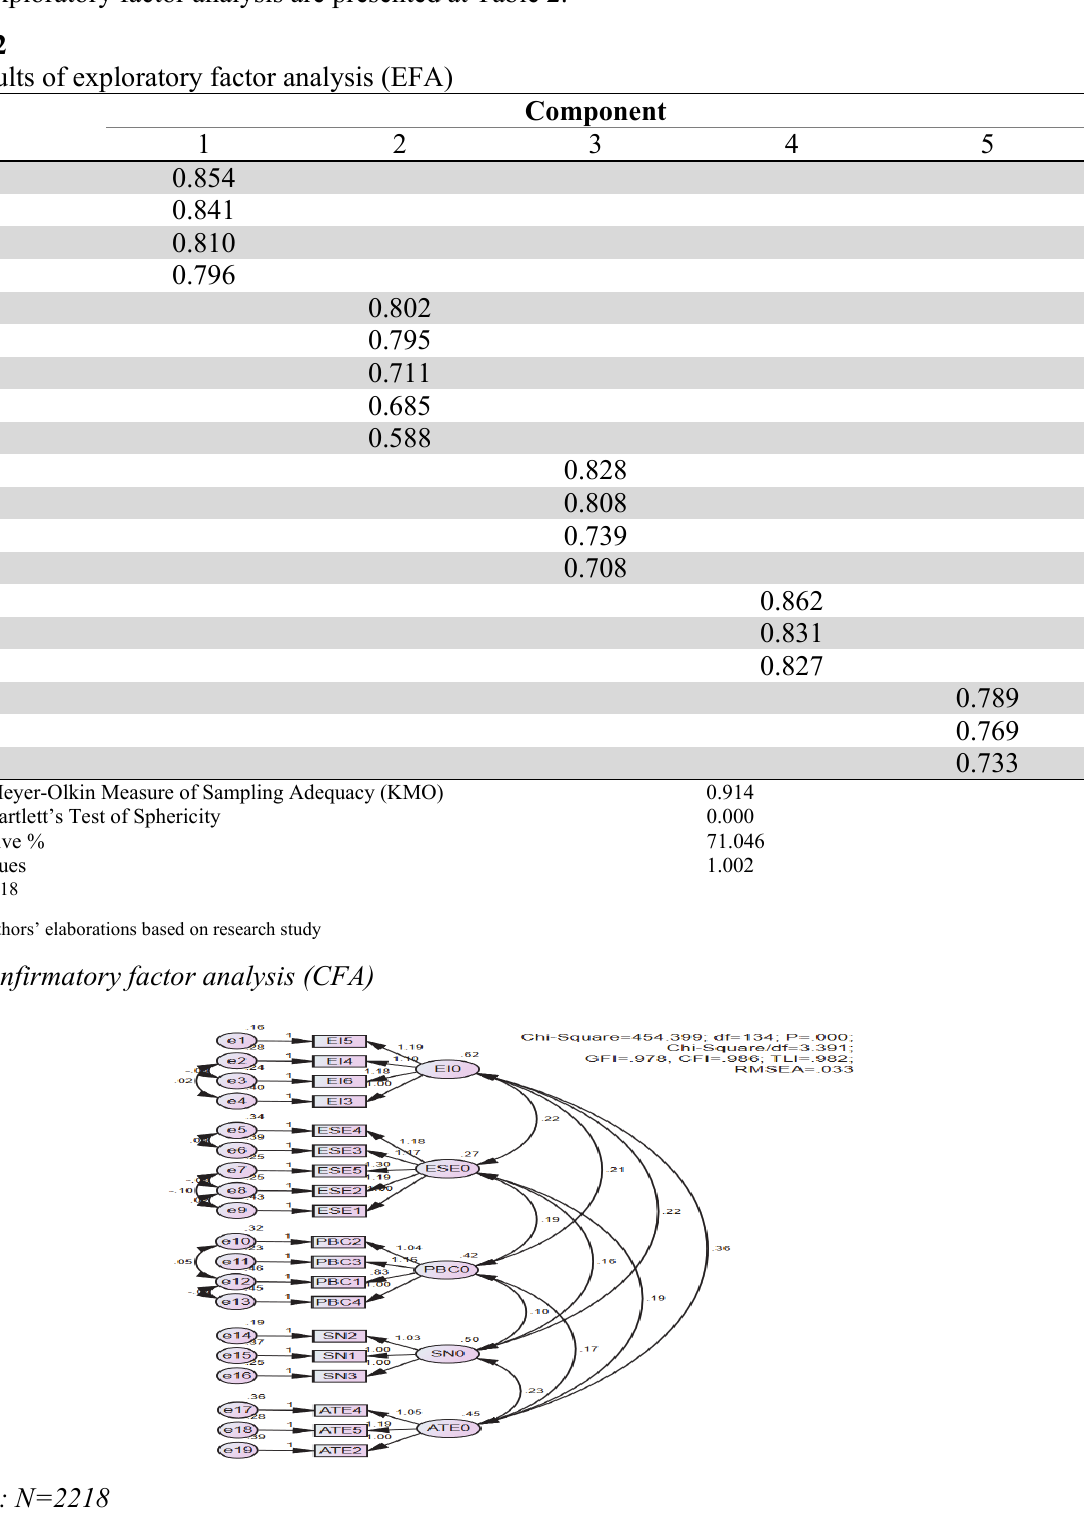
Fig. 2. The results of confirmatory factor analysis (unstandardized